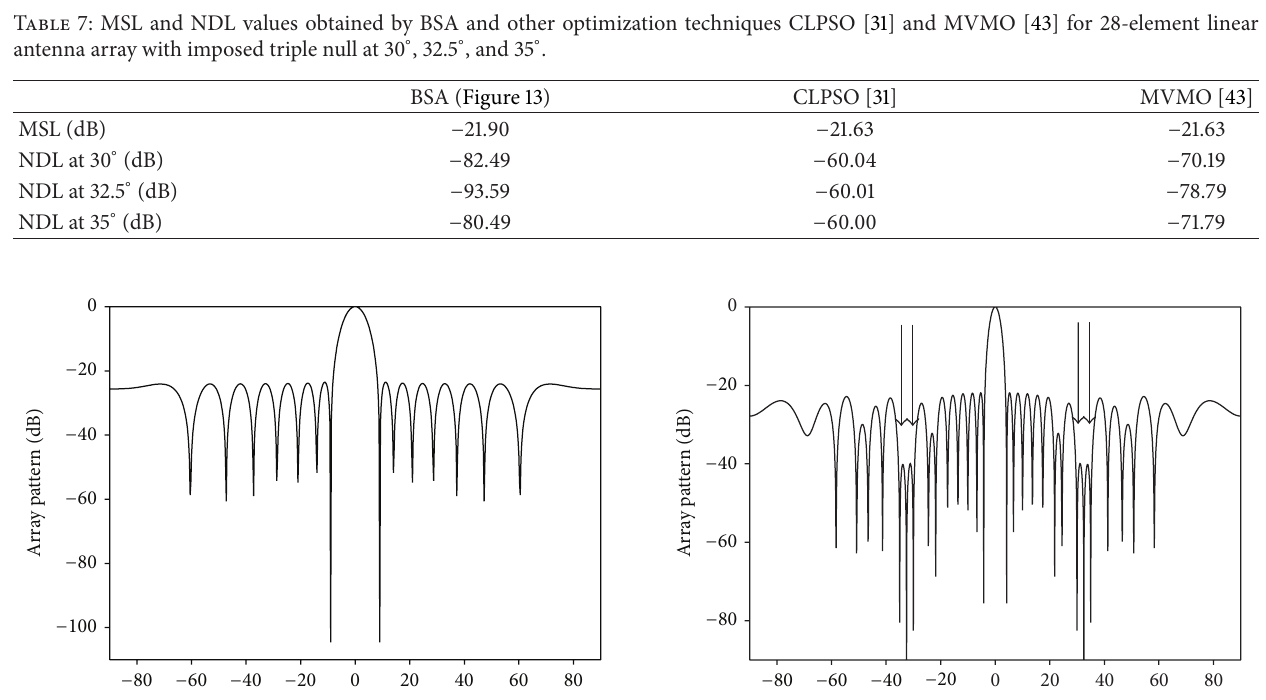
of 9 ∘ and low MSL. The radiation pattern achieved by BSA is given in Figure 14. In Table 8, NDL and MSL values of the pattern obtained by BSA are compared with NDL and MSL values of the patterns obtained by PSO [15], HSA [35], and QPM [15]. It is apparent from Table 8 that NDL and MSL values of the radiation pattern obtained by BSA are better than those of PSO [15], HSA [35], and QPM [15]. The position values of the antenna array elements calcu- lated by BSA for the radiation patterns in Figures 12–14 are given in Table